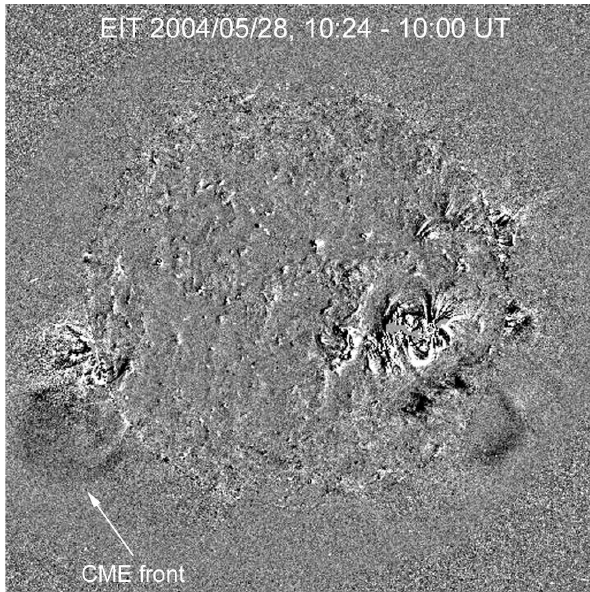
Fig. 2. EIT 195 ˚A difference image on 28 May 2004, showing, in the south-eastern hemisphere, the initiation of the 11:06UT CME at lower coronal levels than shown in LASCO images.